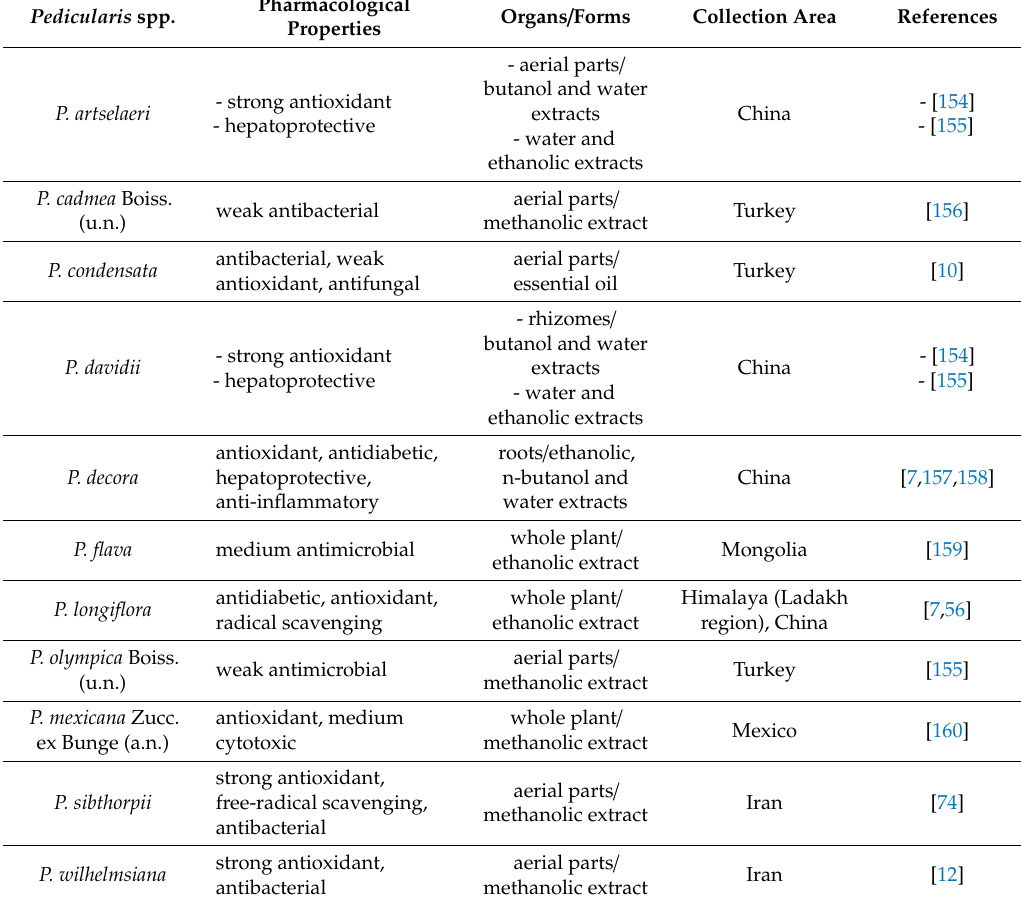
Table 4. Pharmacological Activities of Pedicularis Species as Reported in Literature. Pedicularis